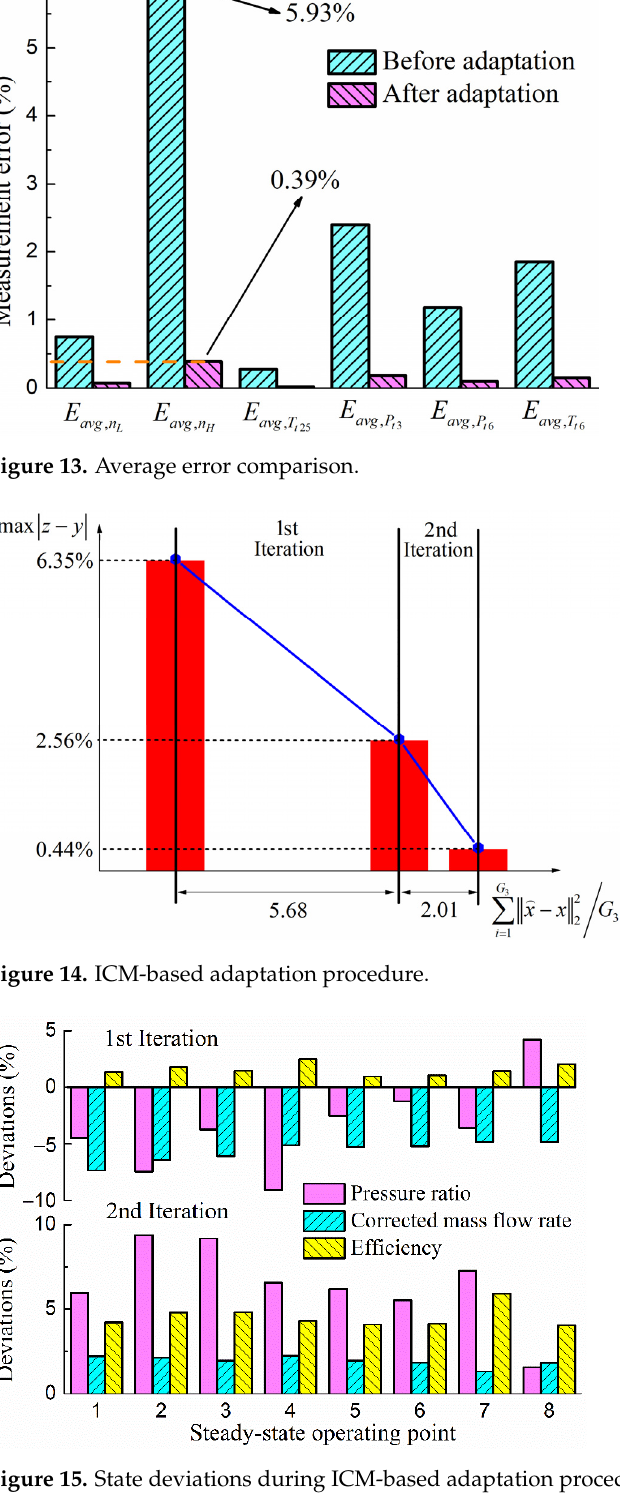
Figure 15. State deviations during ICM-based adaptation